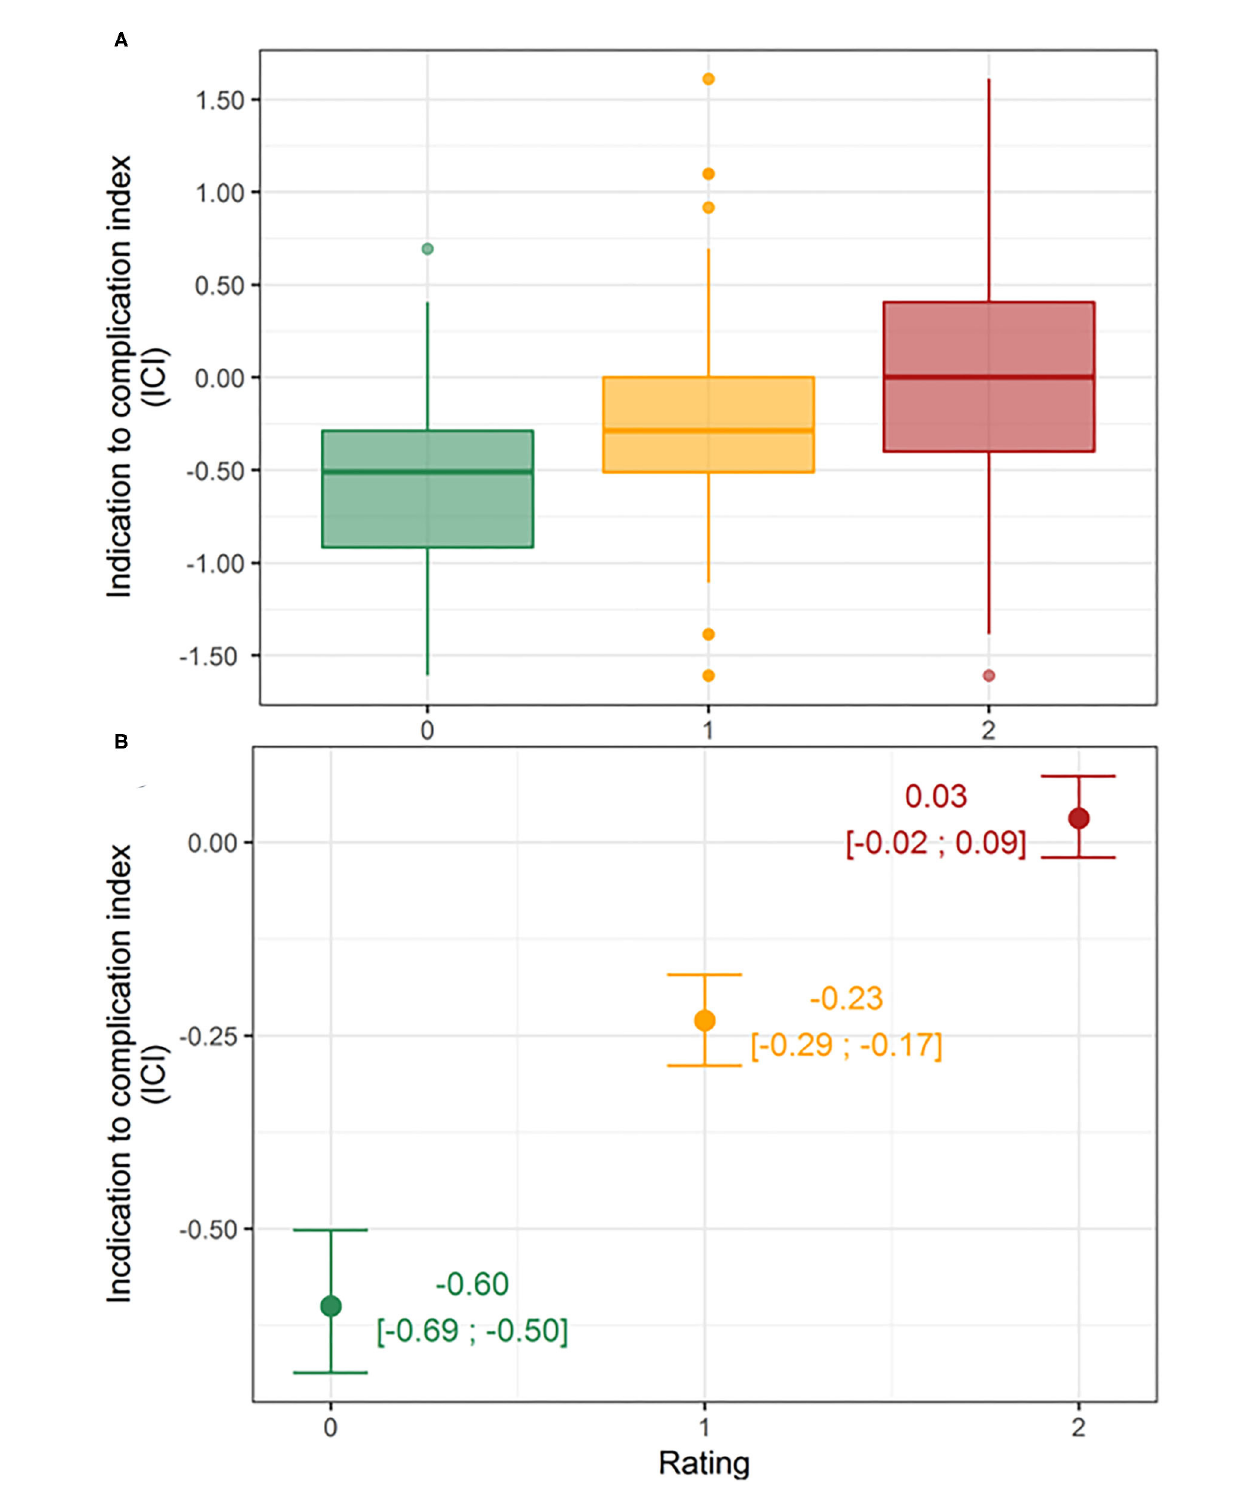
FIGURE 2 | Distributions of Indication to Complication Index (ICI) by rating group. Boxplots (A) and estimated means (95% CI) per rating group derived by the linear mixed-effects model (B) .